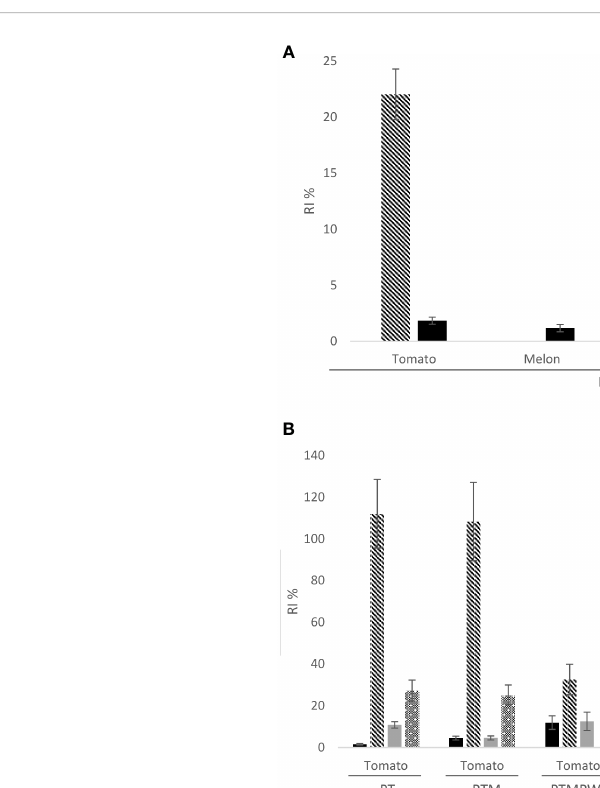
TABLE 3 N° of egg masses plant -1 , egg plant -1 and eggs egg mass -1 produced in the tomato cv. Durinta (S) and Monika (R) of M. incognita after each crop of the rotation scheme (tomato (P T )- melon (P TM )- watermelon (P TMPW )- tomato (P TMPWT )) on the cultivar and rootstock crop lines of the avirulent (VarAvi and RootAvi) and virulent (VariVi and RootVi) subpopulation, and those produced in the melon cv. Paloma (S) and Cucumis metuliferus (R) and in the pepper cv. Tinsena (S) and Oscos (R) from the root subpopulations obtained after the last tomato crop (P TMPWT ) in 200cm -3 pot experiments.